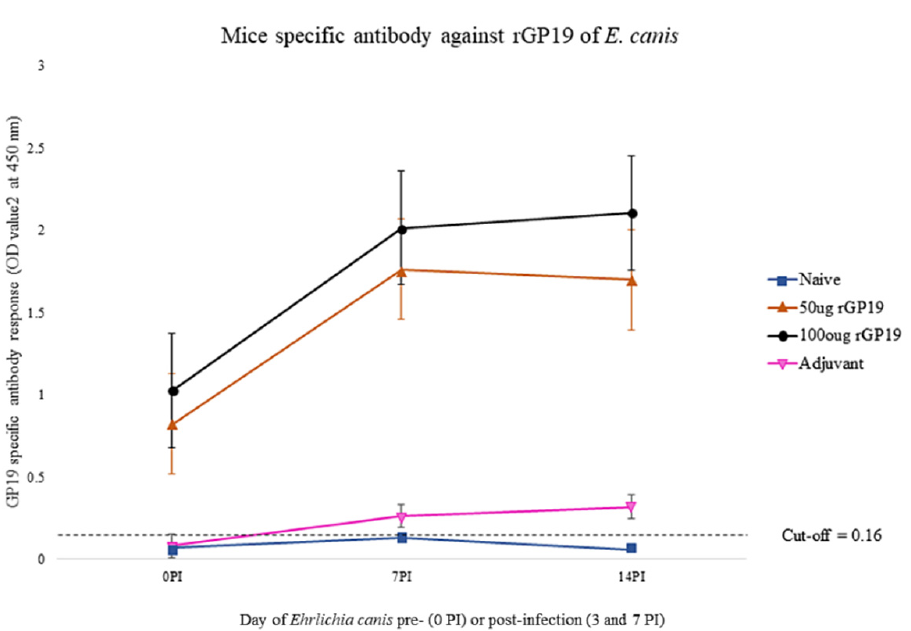
Figure 2. The association between antibody responses induced by the rGP19 vaccine and the develop- ment of antigen-specific antibody responses, pre- and post- E. canis infection in mice. rGP19 vaccine prototypes provide the protection against the pathogen measured by an ELISA using a purified rGP19 as the antigen on day 0 (pre- Ehrlichia canis challenging), and days 7 and 14 (post- E. canis challenging).